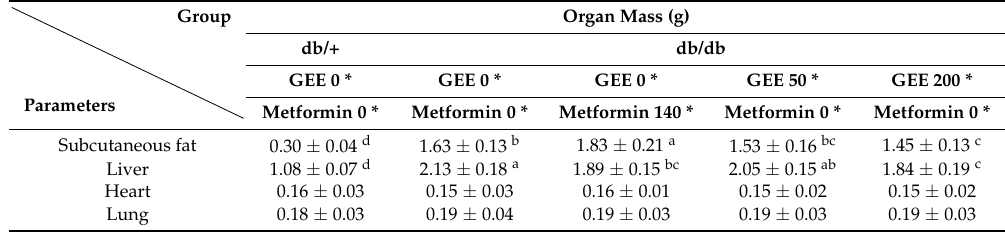
Table 2. Effect of GEE on organ masses in db/db mice.